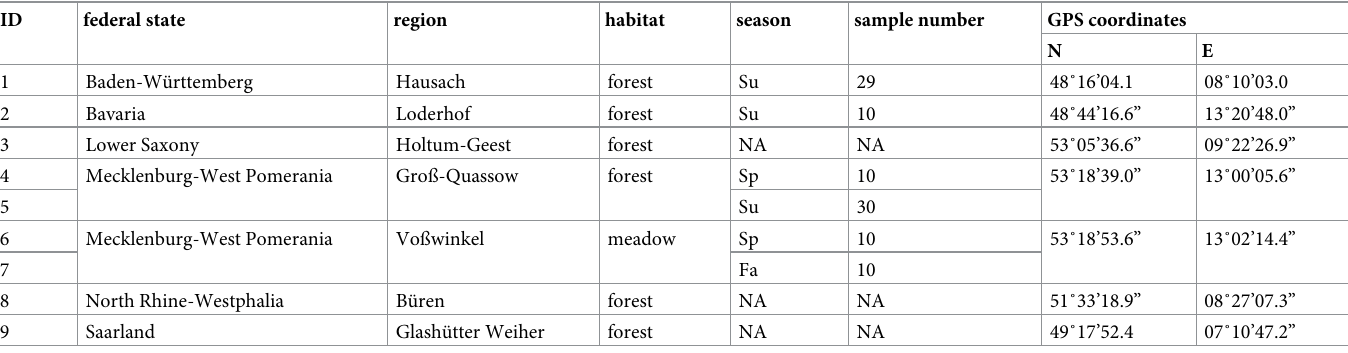
Table 1. Characteristics of collection sites and sample